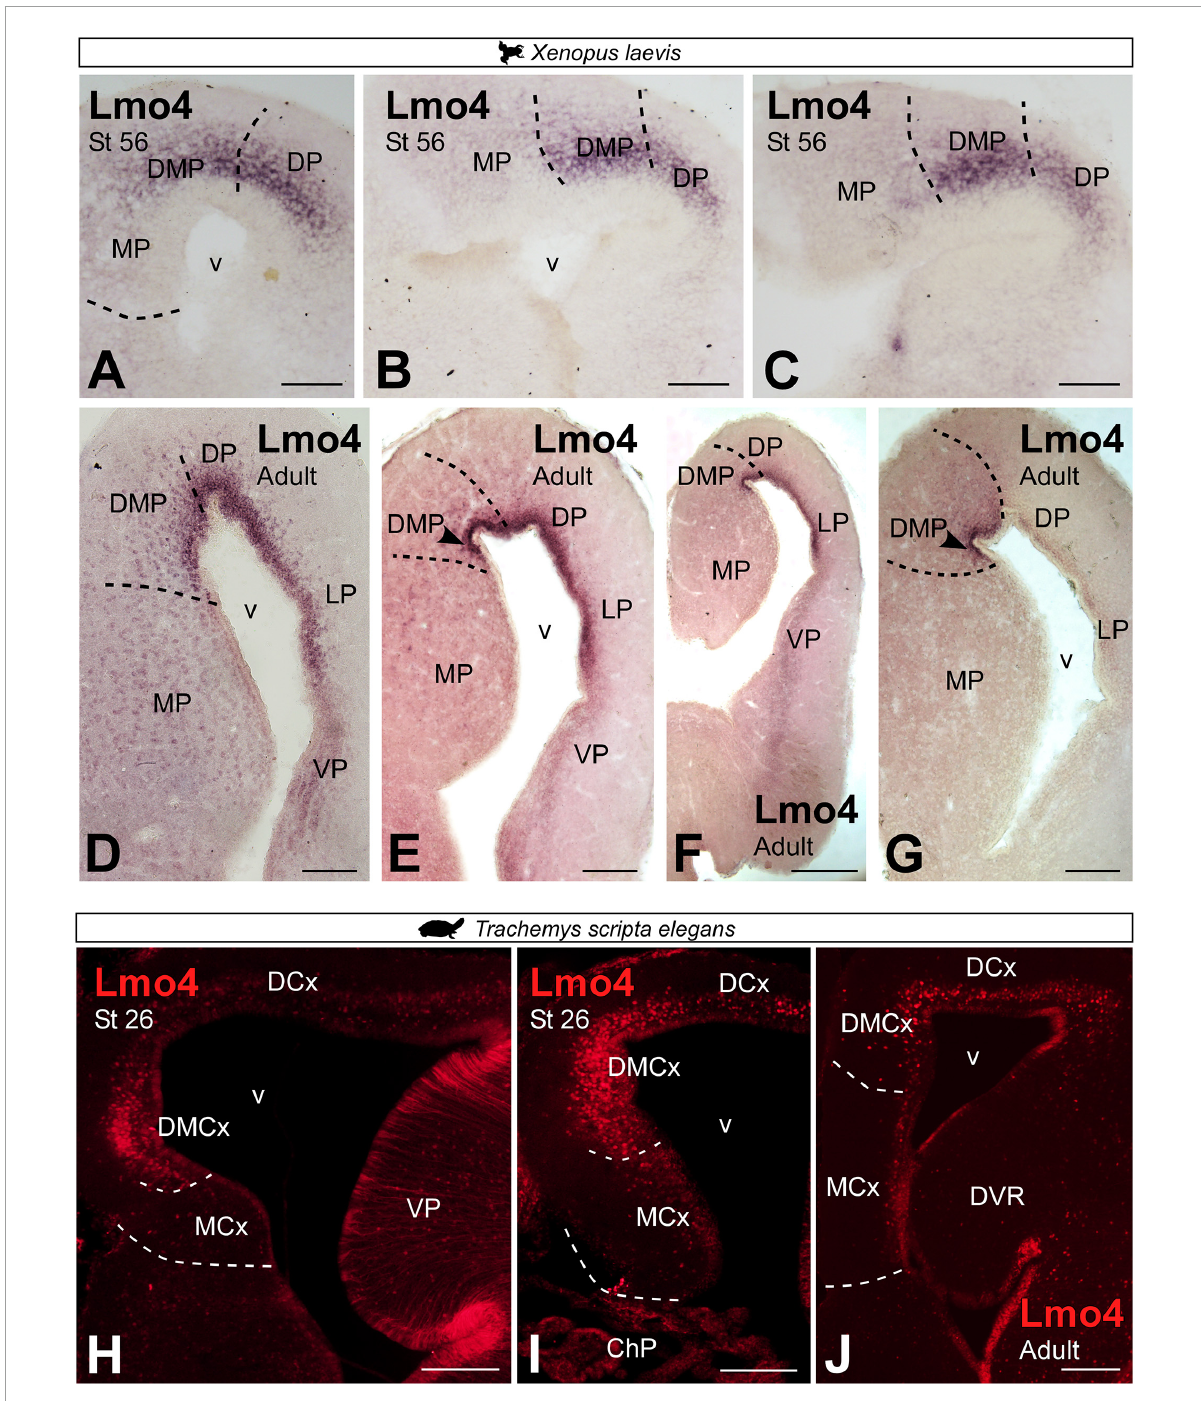
FIGURE9 Photomicrographs of transverse sections through the telencephalon of Xenopus laevis (A–G) and Trachemys scripta elegans (H–J) showing, from rostral to caudal levels, the Lmo4 expression at developmental stages (A–C,H, I) and adults (D–G,J) . Scale bar in panels (A–E,G–J) = 200 µ m and (F) = 500 µ m. See the abbreviation list.